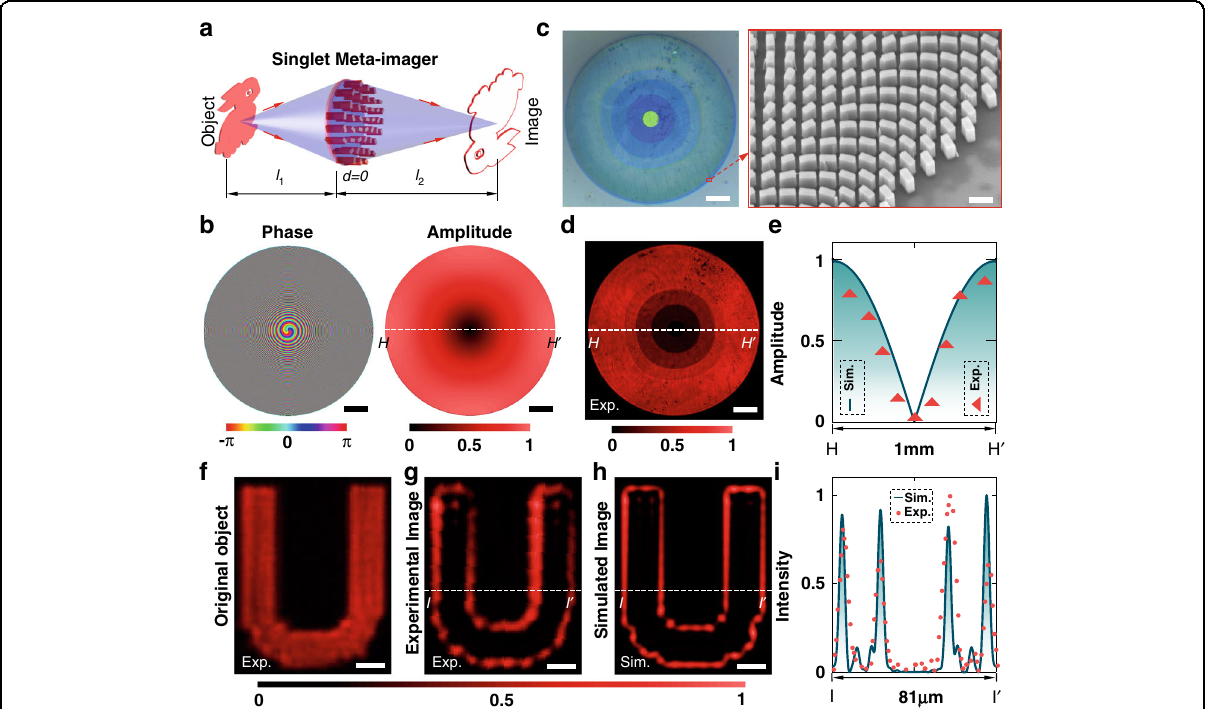
Fig. 5 Singlet meta-imager for edge detection. a Sketch for singlet meta-imager with the object and image distances labeled in l 1 and l 2 , respectively. b Phase and amplitude pro fi les of the meta-imager realizing the edge detection. Its phase is obtained by adding both phases of metalens ( f = 2.5 mm) and meta-modulator. The amplitude modulation comes from only the meta-modulator part because the metalens has an amplitude of 1. Scale bars: 100 μ m. c Microscopic (left) and SEM (right) images of our fabricated singlet meta-imager with fi ve discretized amplitudes. These amplitude pro fi les of 1, 0.75, 0.55, 0.3, and 0 are realized by using the nanobricks with ( W = 110 nm, L = 160 nm), ( W = 110 nm, L = 150 nm), ( W = 110 nm, L = 140 nm), ( W = 110 nm, L = 130 nm) and ( W = 150 nm, L = 150 nm), respectively. Scale bars: 100 μ m (left panel) and 300 nm (right panel). d Transmitted (cross-polarized part) pattern of the singlet meta-imager under the circular-polarization illumination. Scale bar: 100 μ m. e Experimental (triangles) and simulated (curves) amplitude pro fi les along the line HH ′ (see ( b , d )). The experimental amplitude pro fi les are extracted from the measured transmission. f – h Characterization of edge detection by using the singlet meta-imager. The original binary-amplitude object f is located at the input plane of the singlet meta-imager, which yields the experimental ( g ) and simulated ( h ) edges with M = 1. Scale bars: 10 μ m. i Experimental (dots) and simulated (curves) intensity pro fi les along the line II ′ (see ( g , h